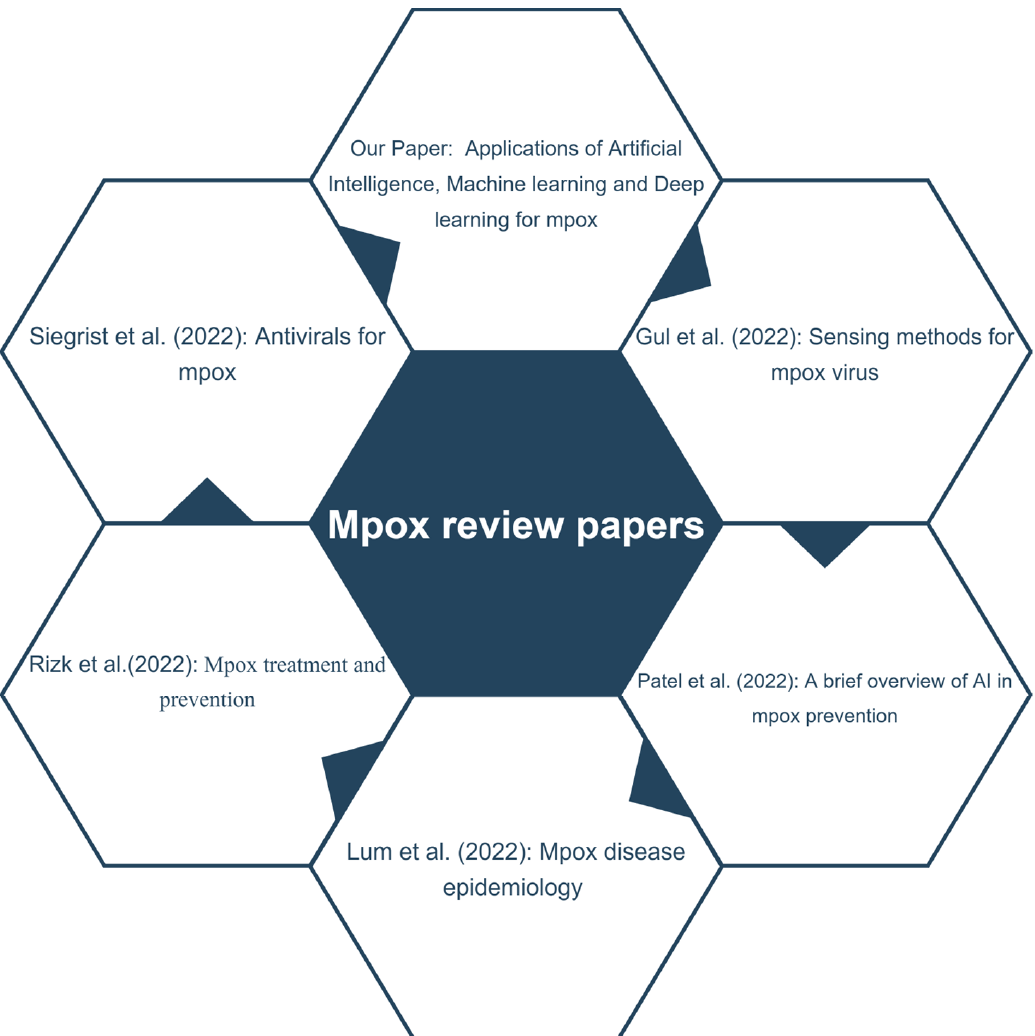
Figure 2. Illustration of comparison with existing review papers published on mpox detection. Siegrist et al. [16], Rizk et al. [17], Lum et al. [18], Patel et al. [19] and Gul et al. [20].